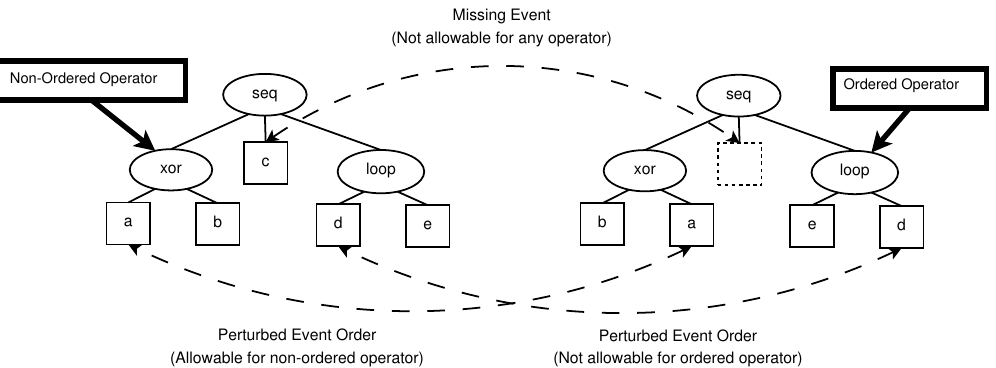
Figure 9. An illustration of execution relation comparison between two process trees for behavior verification. The process tree on the left is a process tree representing normal behavior, and the process tree on the right represents observed